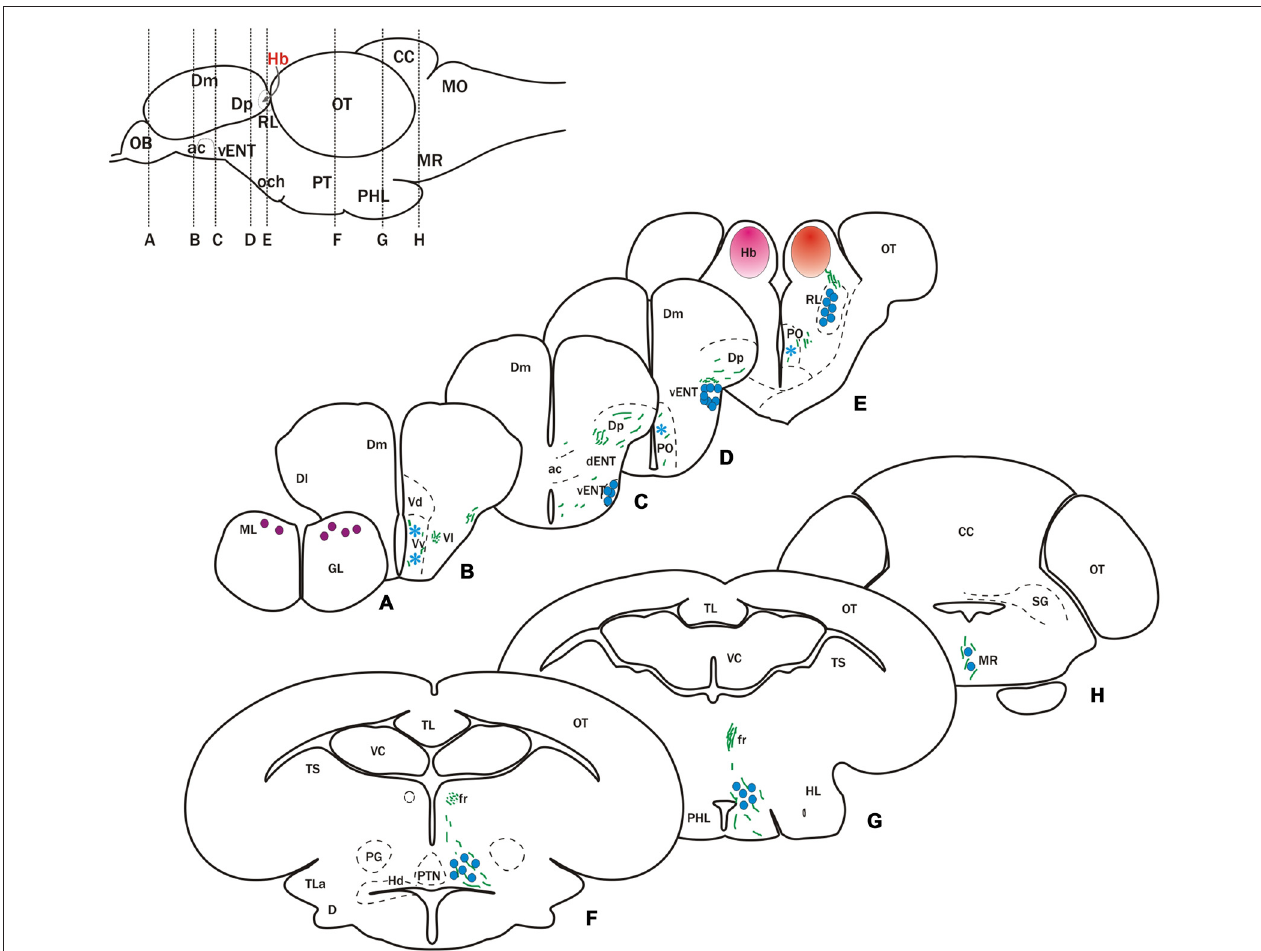
FIGURE 2 | Cells and fibers labeled after DiI application to the habenula. Schematic at the top left shows a lateral view of the brain indicating position of transverse sections shown in (A–H) . (A–H) Schematic representation of transverse sections showing labeled fibers (green lines) and neurons (circles and asterisks) after DiI application to the left (pink circle in E ) or right (red circle in E ) habenula. Blue circles denote cells that project bilaterally to both habenulae, while purple circles indicate cells project only to the right habenula. Asterisks indicate occasionally labeled cells. Parapineal cells, which project to the left habenula, are not represented.